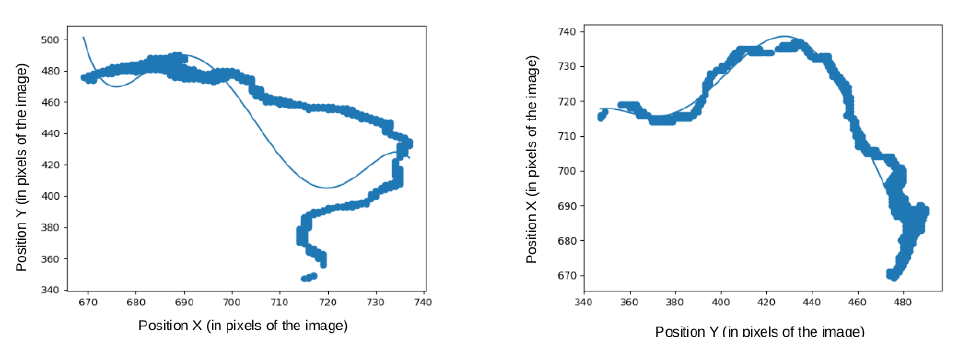
Figure 6. The point cloud represents the selected bin, and the x and y axes are the coordinates of the bins within the study image. On the left is a 4th-order polynomial regression of the elevation bin given the X coordinates; this regression is ineffective and achieves a low R 2 -score. On the right is a 4D polynomial regression of the bins given the Y coordinates; this regression is effective and achieves a better R 2 -score than the first approximation. We then use it for the active contour initialization.